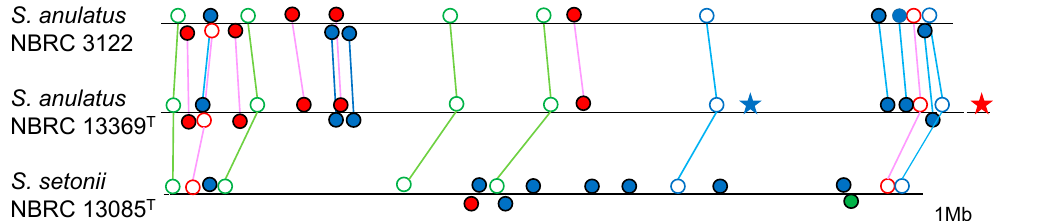
Figure 6. PKS and NRPS gene clusters on linear chromosomes of three strains showing 100% 16S rRNA gene sequence similarity. Red, PKS gene cluster; blue, NRPS gene cluster; green, hybrid PKS/NRPS gene cluster; open circle, conserved between di ff erent species; closed circle, speci fi c to each species; star, strain-speci fi c. The same gene clusters are connected by colored lines. All 19 clusters of S. anulatus NBRC 3122 are conserved in S. anulatus NBRC 13369 T . Between the two S. anulatus strains, only two clusters are speci fi c to strain NBRC 13369 T . Among the 19 to 21 and 18 clusters of the S. anulatus strains and S. setonii NBRC 13085 T , respectively, only eight are conserved between the two species. Between the two species, 11 to 13 are speci fi c to S. anulatus whereas 10 are speci fi c to S. setonii . Although strain NBRC 3122 is published as S. griseus in the NBRC Culture Catalog, it is not S. griseus , but S. anulatus , because its DNA–DNA relatedness to S. griseus DSM 40236 T , S. anulatus NBRC 13369 T and S. setonii NBRC 13085 T is 48.7%, 91.5% and 44.3%, respectively, by dDDH.